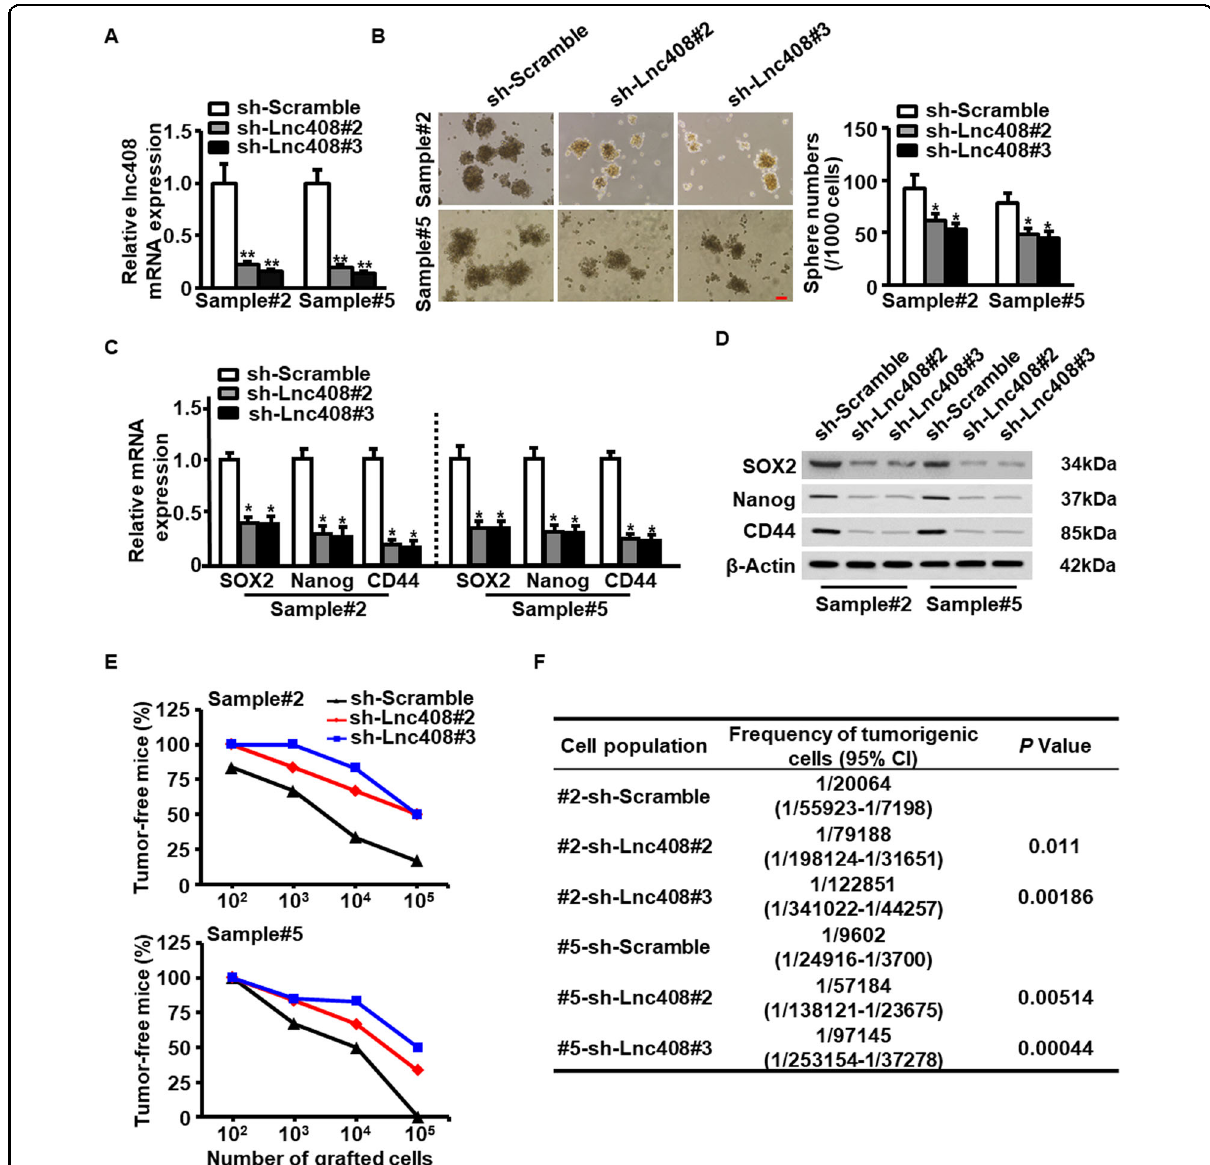
in primary BC cells (** P < 0.01). B Mammosphere-forming capacities in primary BC cells with silenced lnc408 were evaluated by suspended culture, and representative images were shown. The right panel represents the statistical results of mammosphere numbers as means ± SD (* P < 0.05; scale bar, 100 μ m). C , D BCSC stemness markers (SOX2, Nanog, and CD44) were assessed in lnc408-depleted cells by qRT-PCR ( C ) and western blotting ( D ) (* P < 0.05). E Lnc408-depleted or control primary BC cells were transplanted into mammary fat pads of nude mice in tenfold serial dilution manner. Tumor initiation and tumor sizes were monitored over 2 months ( N = 6 for each group). F Frequency of tumorigenic cells in lnc408-depleted